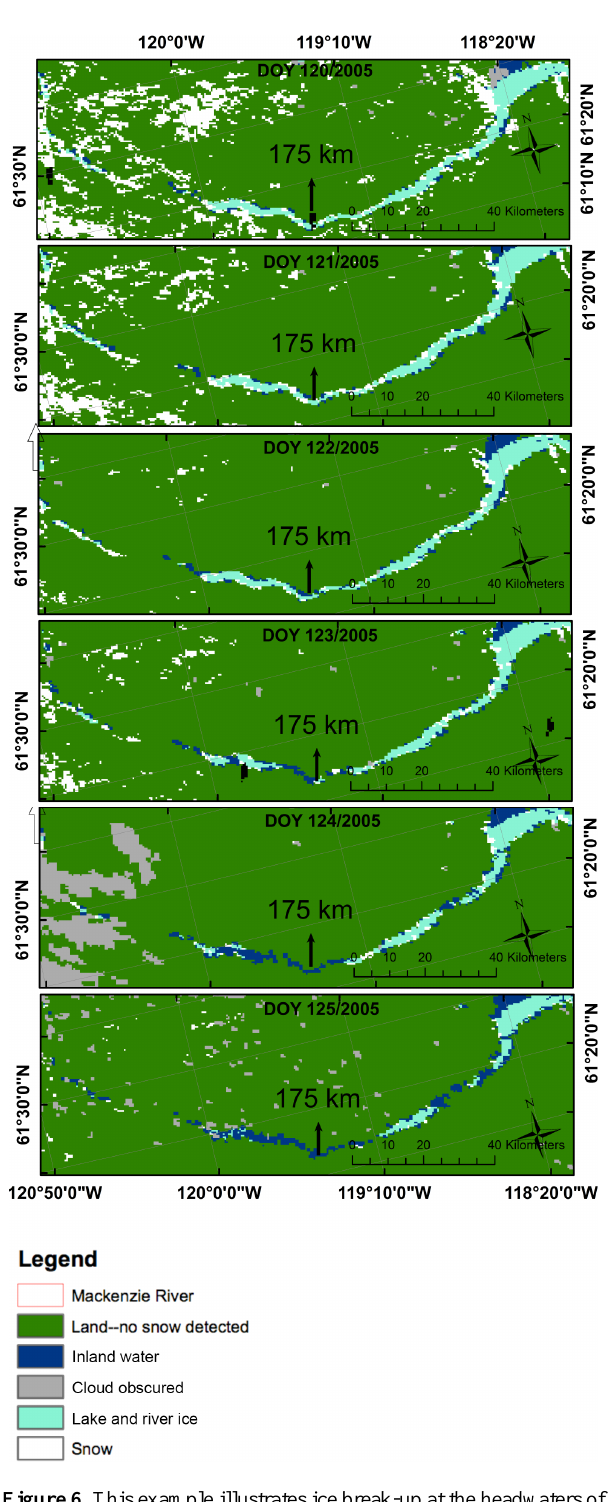
Figure 6. This example illustrates ice break-up at the headwaters of the Mackenzie River system in 2005 from DOYs 120 to